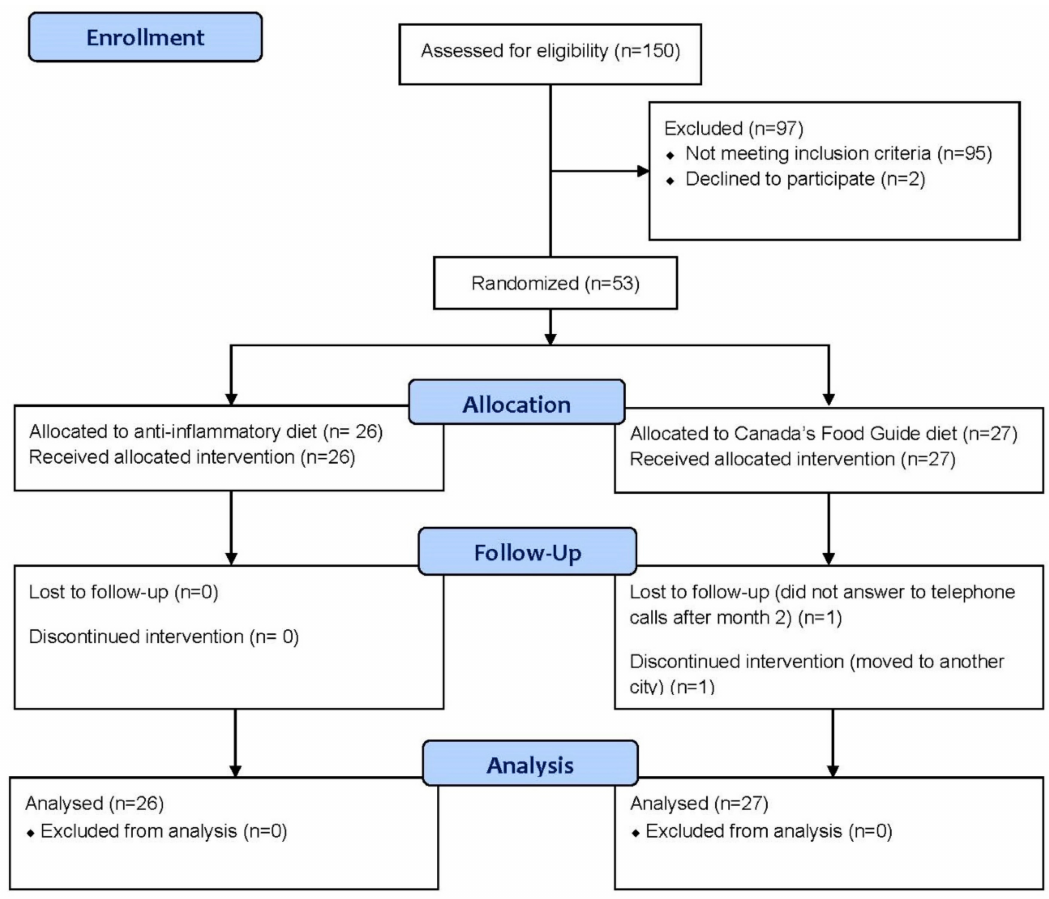
Figure 1. CONSORT flow